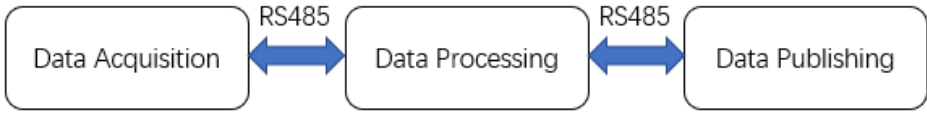
Figure 6. Overall architecture of the lithium battery monitoring system.